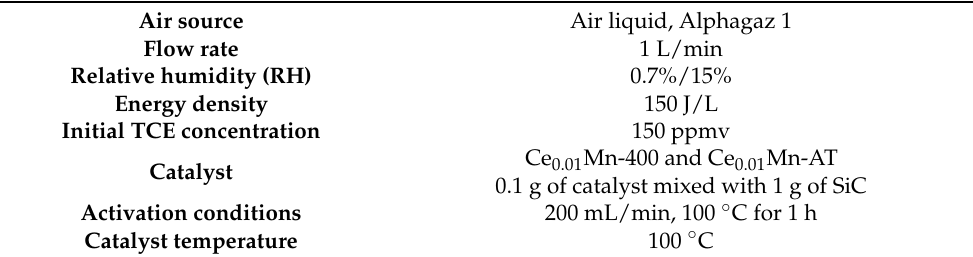
Table 4. Experimental conditions for the PPC